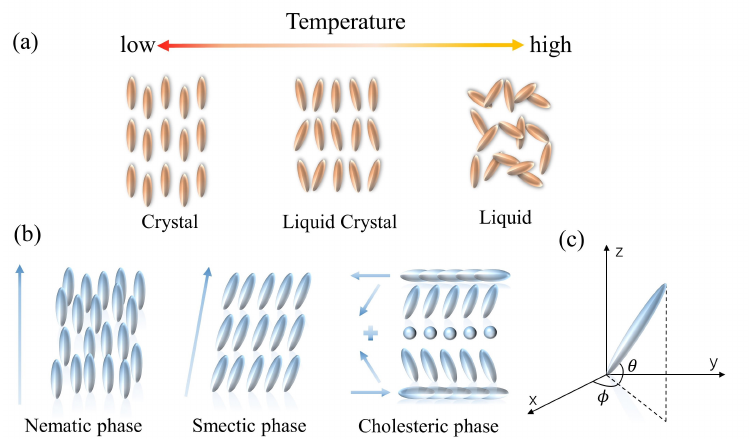
Figure 1. Schematic of the properties of LC molecules. ( a ) The arrangement of thermotropic LC molecules. ( b ) The variation of thermotropic LC molecules with temperature. ( c ) Illustration of LC directors in the Cartesian